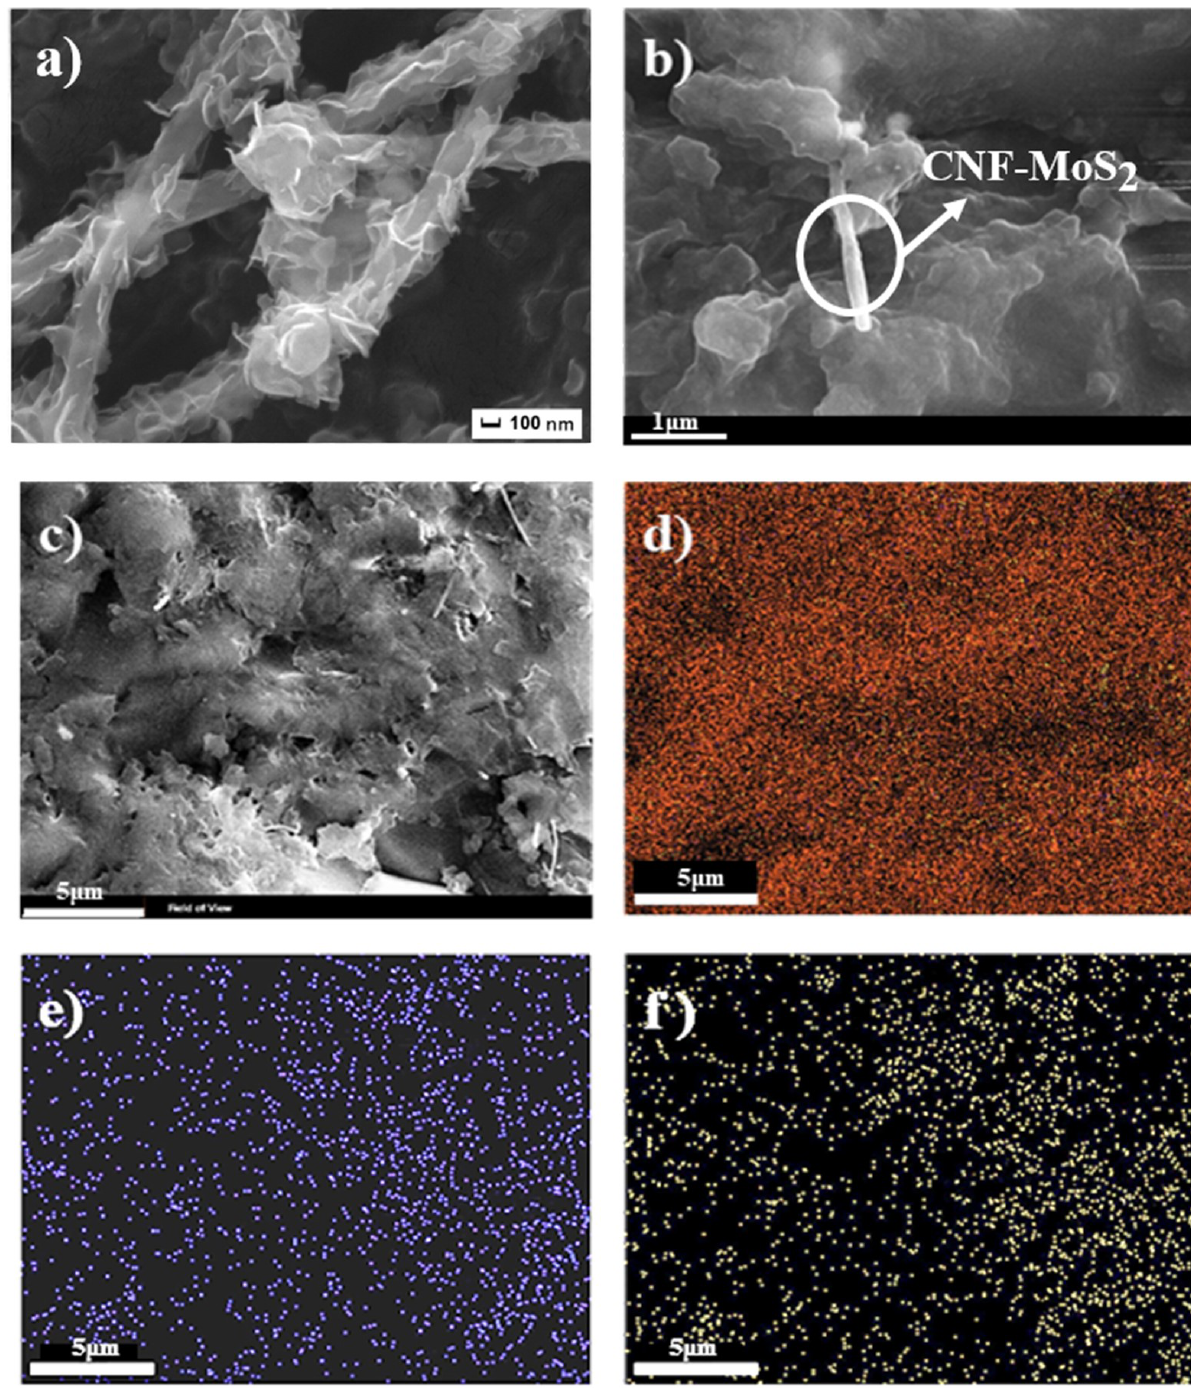
Figure 5: Microstructure of EP/CNF-MoS 2 : a) TEM image of CNF-MoS 2 , MoS 2 nano-sheets are uniformly coated on the surface of CNFs; b) SEM image of a single CNF-MoS 2 hybrid in the coating; c) A rectangle area selected for EDS composition scanning; d), e), and f) are the results of the EDS composition scanning; d) Total components including C, Mo and S; e) Mo; f)